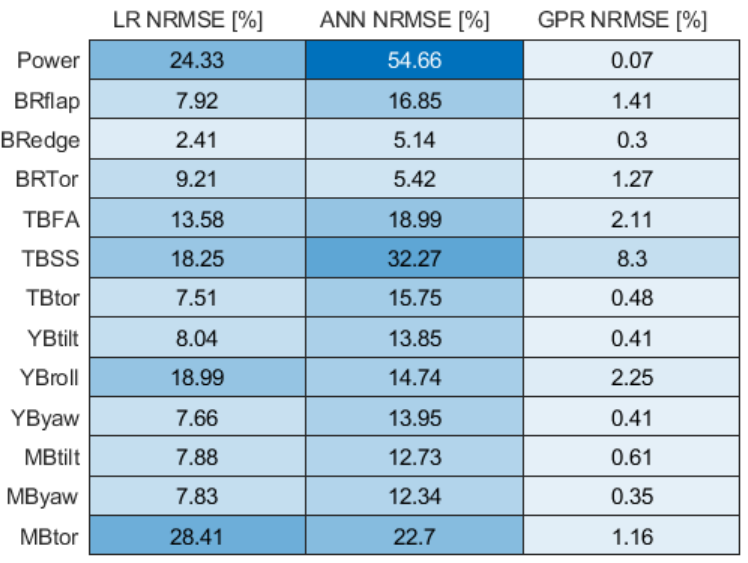
Figure 3. Normalised root mean squared error (NRMSE) for all predicted variables for Linear Regression (LR), Artificial Neural Network (ANN) and Gaussian Process Regression